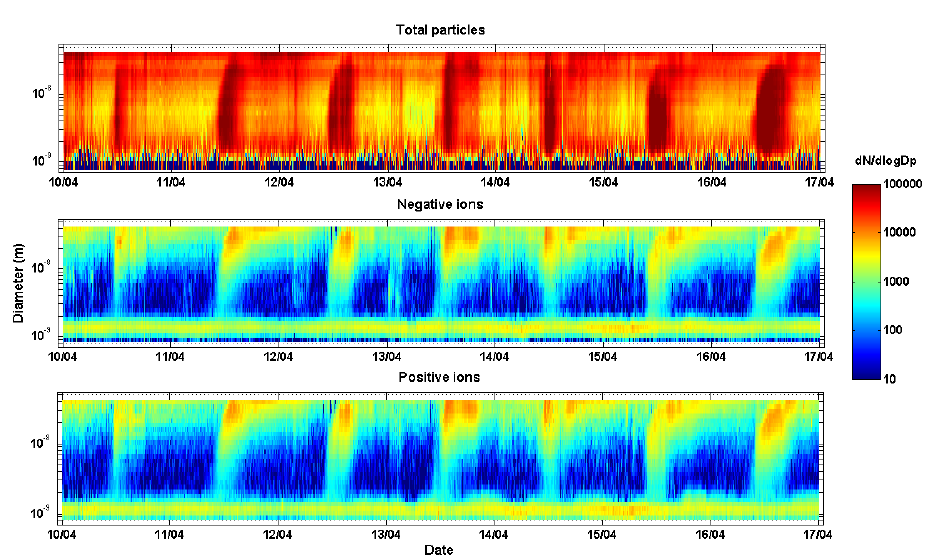
Fig. 2. Particle and ion number size distribution measured with the NAIS on seven consecutive new particle formation event days on 10–16 April 2009 in Melpitz, Germany.